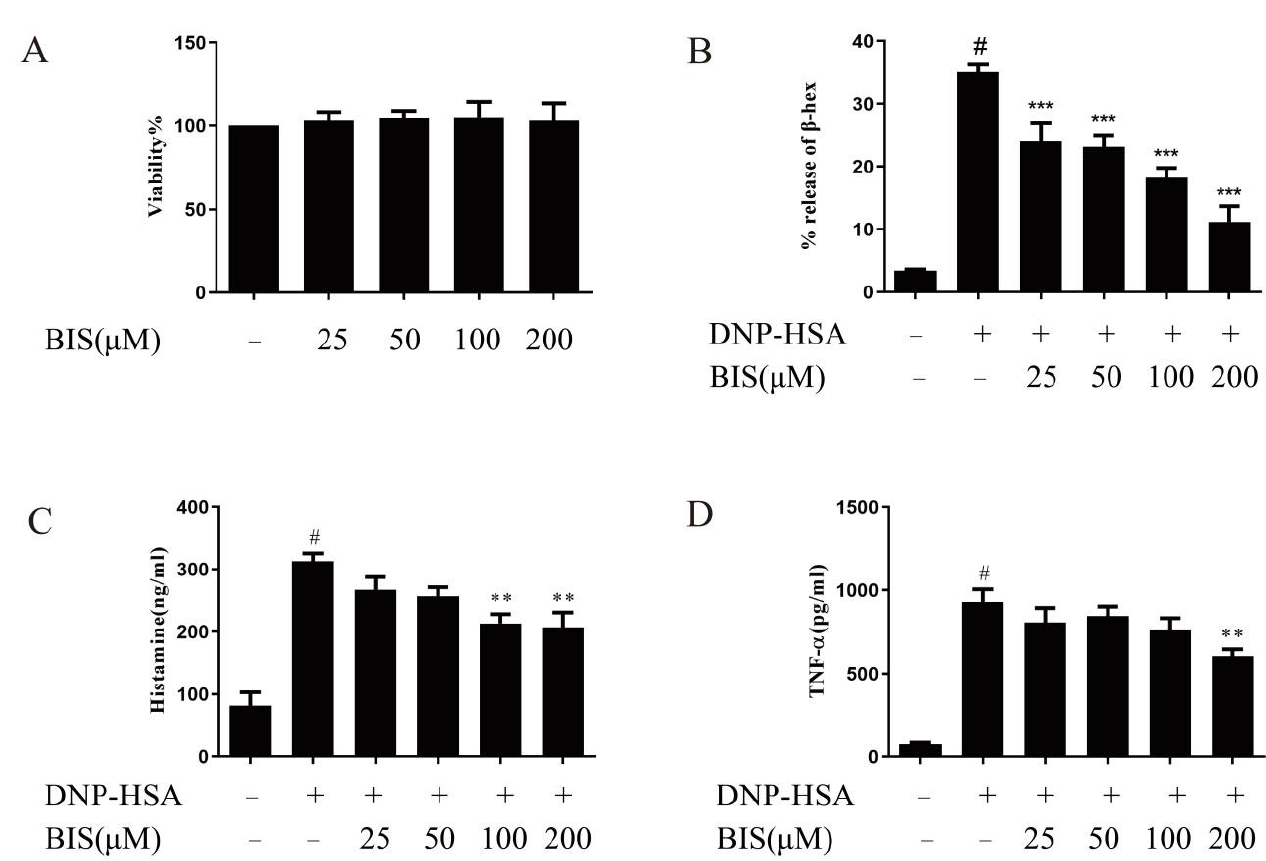
Figure 6. Effect of BIS on IgE/Ag-stimulated BMMCs. ( A ) BMMCs were incubated with different concentrations of BIS and cell viability was determined by XTT assay. IgE-sensitized BMMCs pre- treated with or without BIS for 30 min. Then, the cells were treated with DNP-HSA for stimulation. The release of β -hex ( B ) and histamine ( C ) were measured with DNP-HSA for 30 min. ( D ) Levels of TNF- α were measured with DNP-HSA for 24 h by ELISA. Data represent the mean ± SEM, n = 3. # p < 0.05 vs. Control; ** p < 0.01, *** p < 0.001 vs. Model.